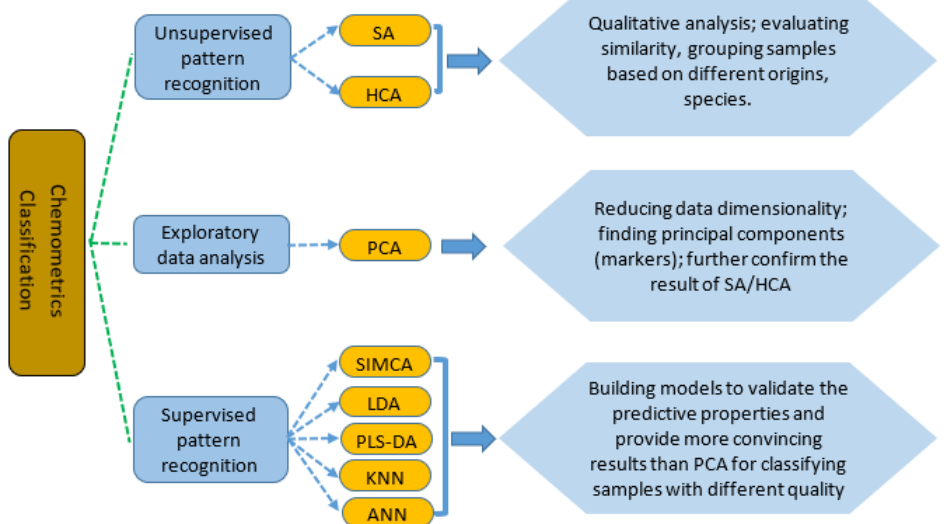
Figure 1. The chemometrics techniques widely applied for the classification of objects. SA = similarity